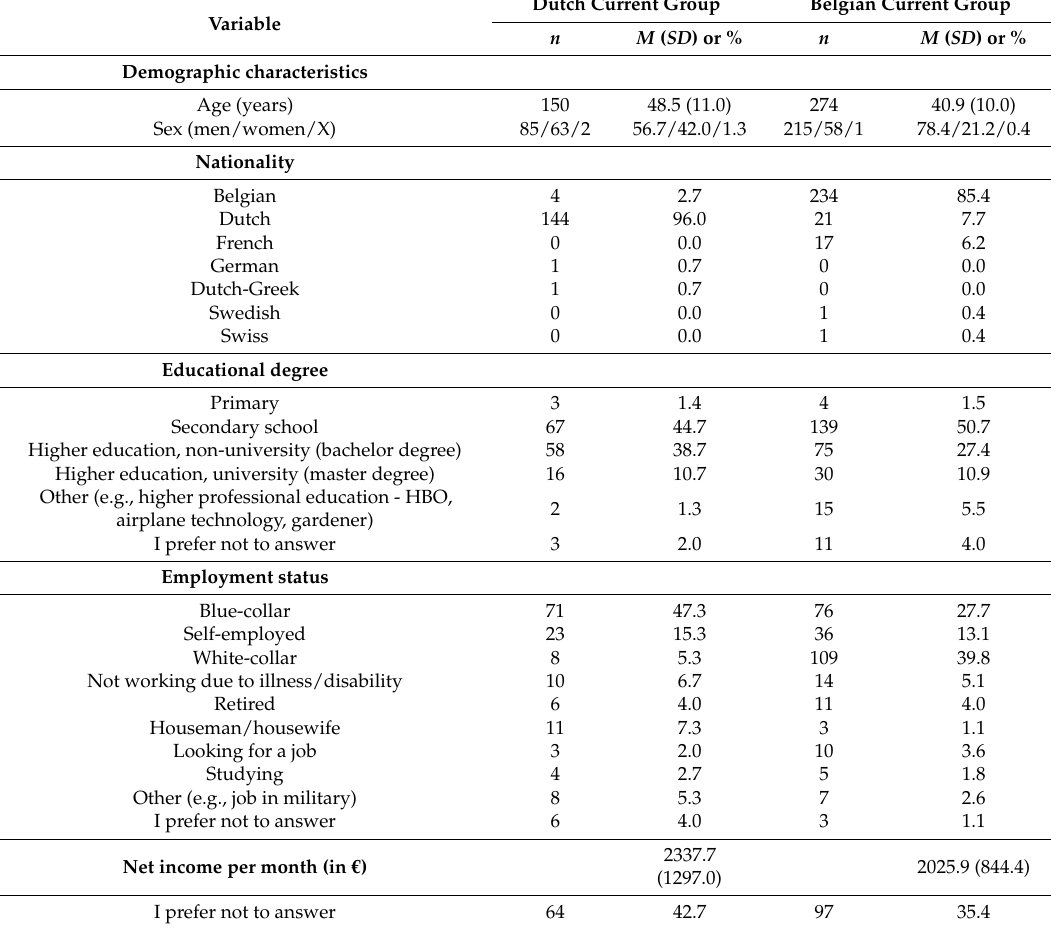
Table A1. Sociodemographic